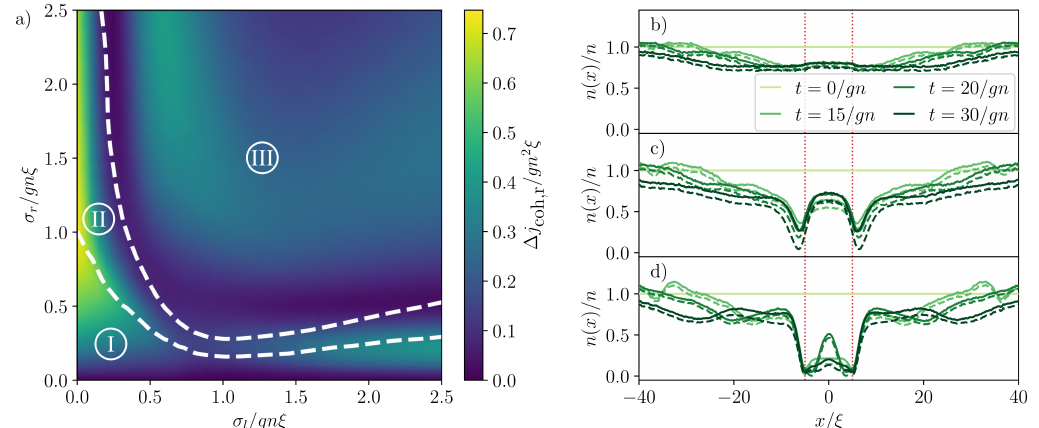
Figure 4: Phase diagram of a configuration of two noisy point contacts. a) Scat- tering rate out of the condensate at the right point contact for impurity separation r = 10 ξ , plotted for different noise strengths σ and σ . The current is averaged over l r time t ∈ [ 25 − 35 ] / gn and space x ∈ [ − 4.5,4.5 ] ξ ; intervals are chosen as in Fig. 3a. The dashed lines mark the border between different phases as in Fig. 3, calculated by assuming a single contact in motion, see main text. b)-d) Density in the vicin- ity of two dissipative point contacts at distance r = 10 at equal dissipation strength σ = σ = σ . Their positions are marked with the red dotted lines. Parameters are r l chosen for both contacts to be in b) the normal phase σ = 0.2 gn ξ , c) the Zeno phase σ = .5 gn ξ and d) the soliton phase σ = 2.2 gn ξ . Solid and dashed lines are chosen as in Fig.